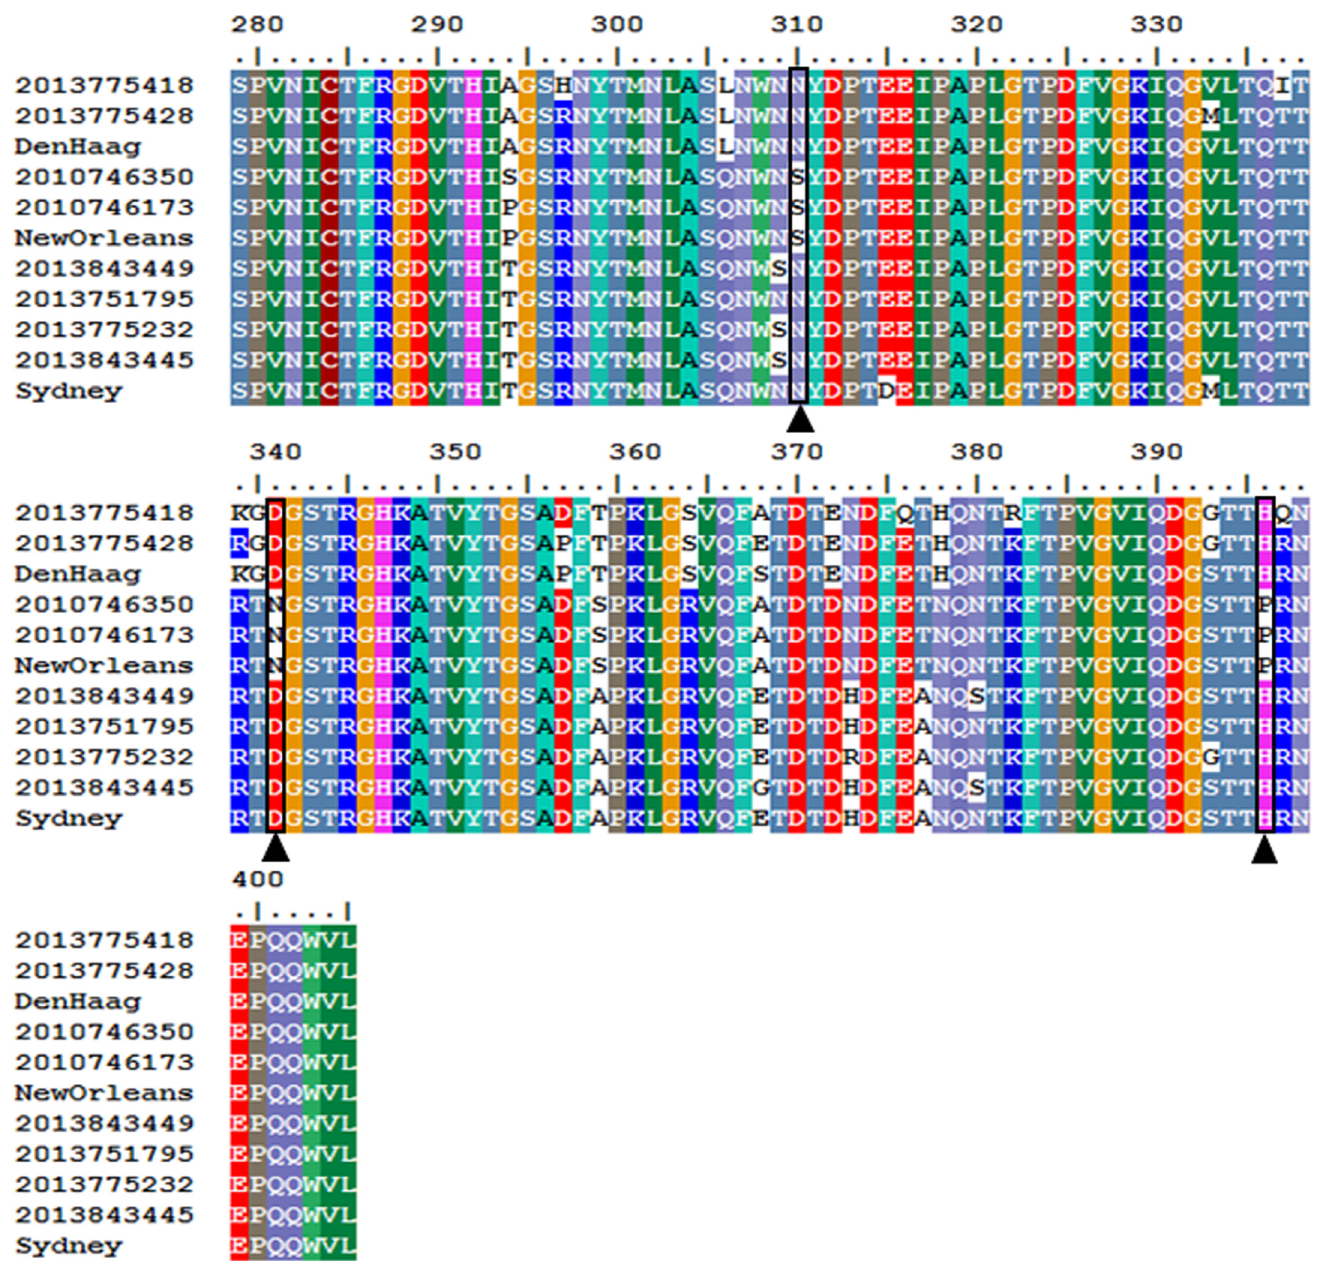
Fig 3. P2 subdomain (amino acids (aa) 279 – 405) sequence alignment of GII.4 Den Haag, GII.4 New Orleans, and GII.4 Sydney viruses. Key amino acid changes, S310N, andN341D, and P396H are indicated with black